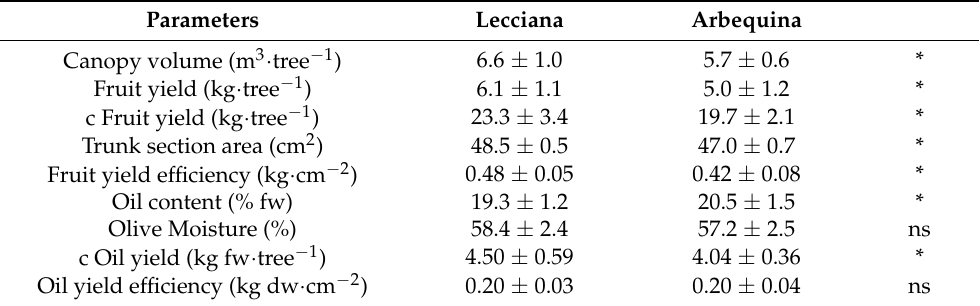
Table 6. Canopy volume, fruit and oil yield, trunk section area and yield efficiencies of ‘Lecciana’ compared with ‘Arbequina’ (fw = fresh weight; dw dry weight). Mean values of 4 years ( ± SE ). c = cumulated values; * = statistical significance at p = 0.05 (Siegel-Tukey test); ns = not significant.